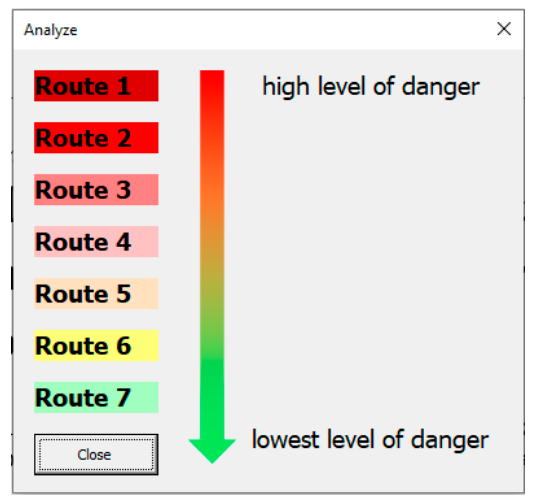
Figure 6. Functionality of the software (sections